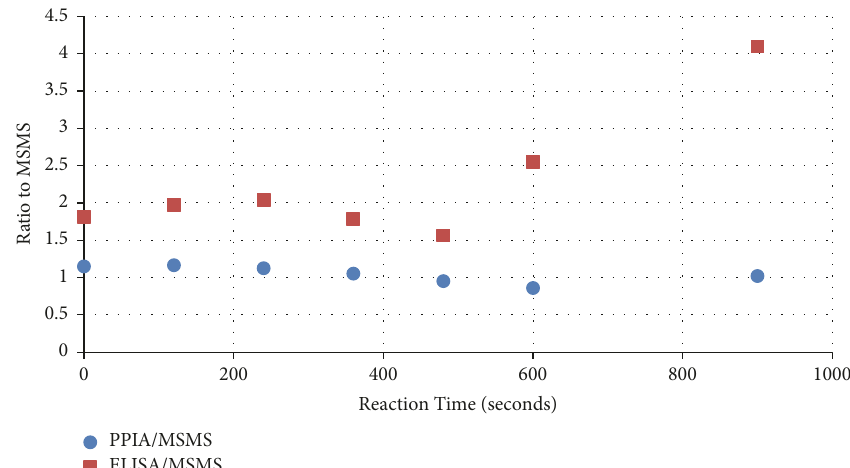
Figure 5: PPIA and Adda-ELISA normalized by LC/HRMS show that the ratio of the response of the Adda-ELISA increases as the reaction